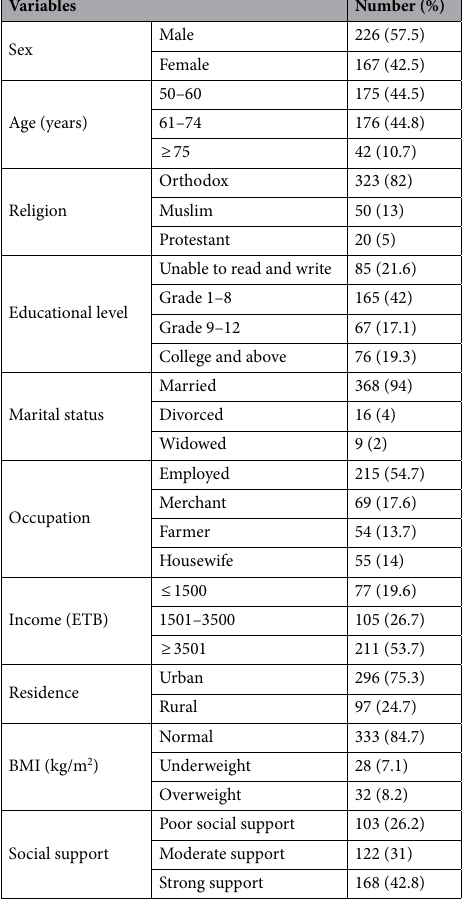
Table 1. Socio-demographic characteristic of study participants on cognitive impairment and associated factors among elders at Gondar town,